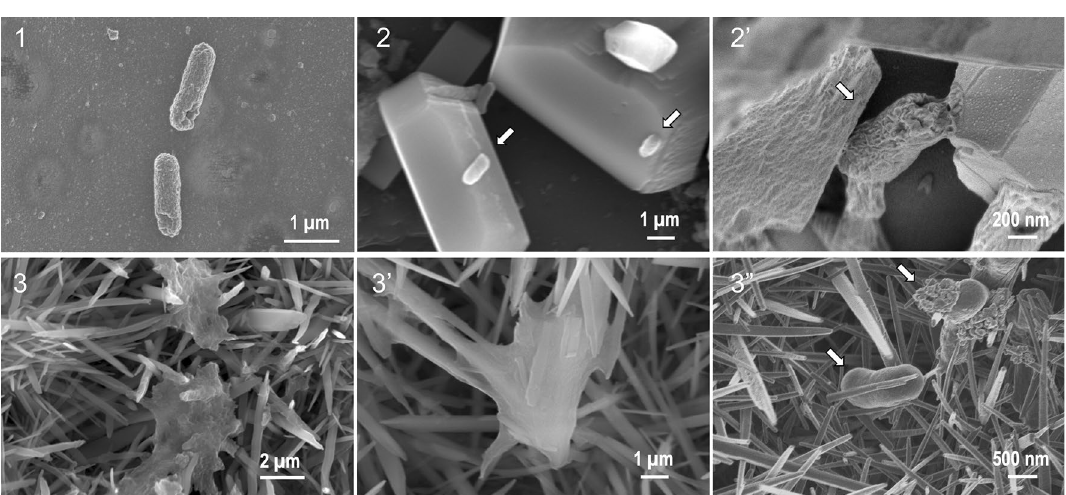
Figure 3. SEM image of E. coli on unmodified and modified TiO 2 ceramic surface after 16 h immersed into E.coli contained water. TiO 2 ceramic surfaces (1), Calcite-modified TiO 2 ceramic surfaces under low (2) and high (2 ′ ) magnification, Aragonite-modified TiO 2 ceramic surfaces under low (3), middle (3 ′ ), and high (3 ″ )